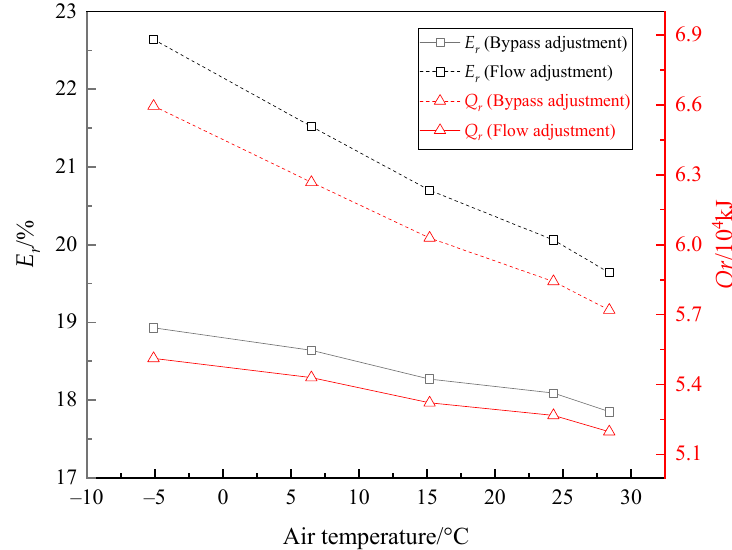
Figure 17. E r and Q r as air temperature changed.